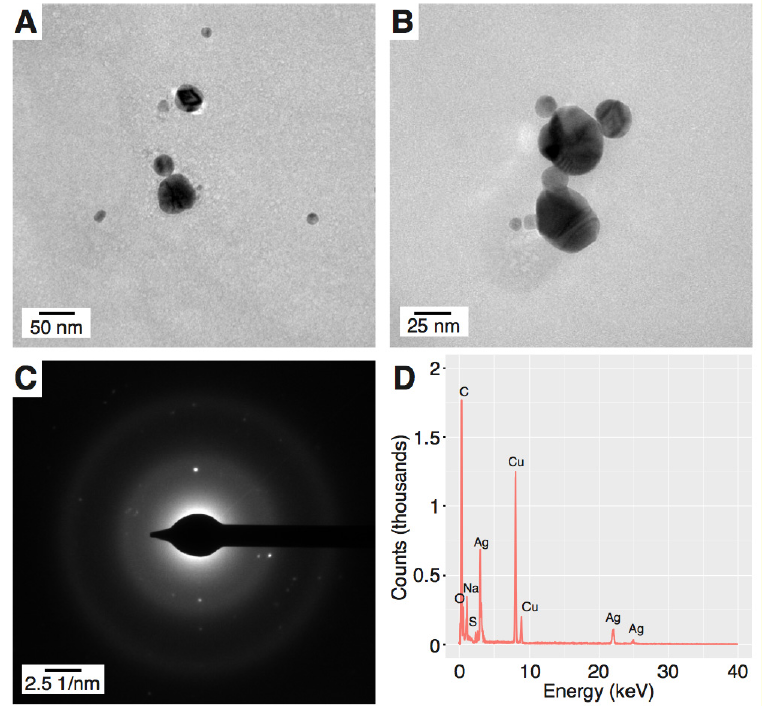
Figure 3. Morphology of the produced SDS-AgNPs. ( A , B ) Representative TEM images; ( C ) the SAED pattern; and ( D ) the EDX spectrum.